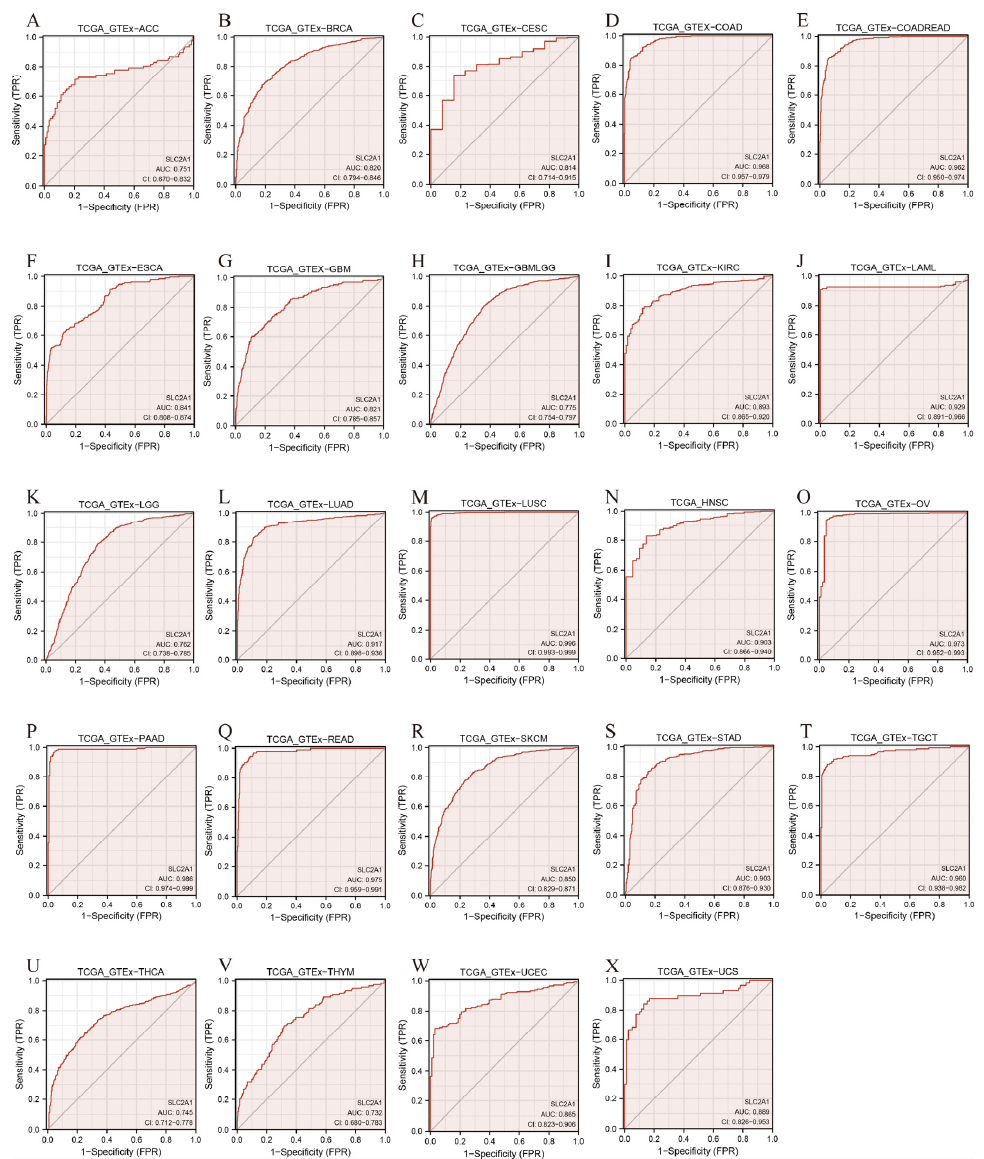
Figure 6. Receiver operating characteristic (ROC) curve for SLC2A1 expression in pan-cancer ( A – X ).